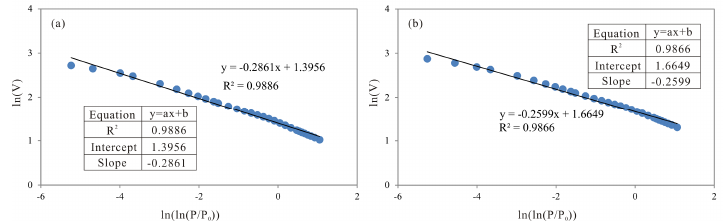
Figure 6. Plots of ln(V) vs. ln(ln(P 0 /P)) reconstructed from the N 2 adsorption isotherms of two typical shale samples: ( a ) Sample SY-1 and ( b ) Sample